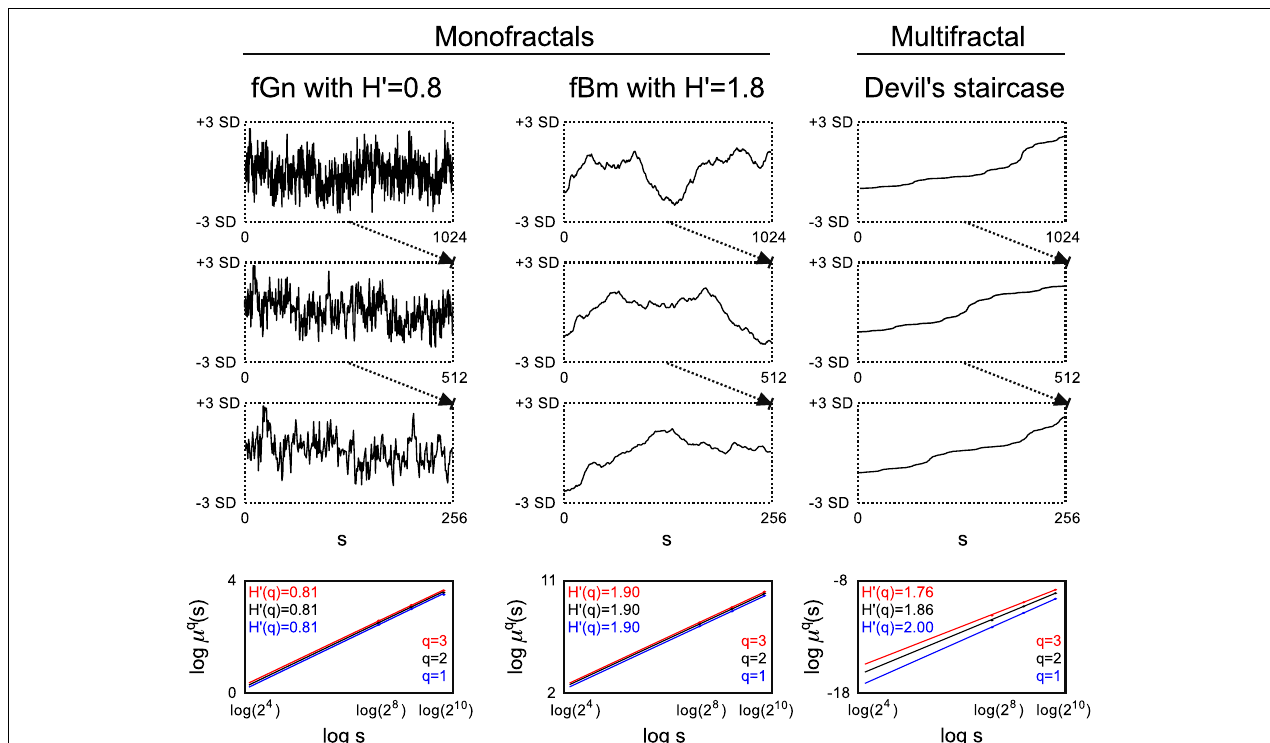
law fashion.Thus as a scale-free descriptor, the extended Hurst exponent ( H (cid:48) ) is calculated as a slope of regression line between the logarithms of the scale ( s ) and F q (For an explanation of H (cid:48) , see main text).The obtained slopes for different magnifications of the time series [here with the order of q = (1, 2, 3), which is the order of moment of the used measure] are the same for monofractals and different for multifractals, demonstrating that power law scaling behavior is a global property of monofractals, while it is a local property of multifractals. Accordingly, note that slopes in the bottom left and middle panel are the same, while in the right panel they indeed differ. For further details, see main